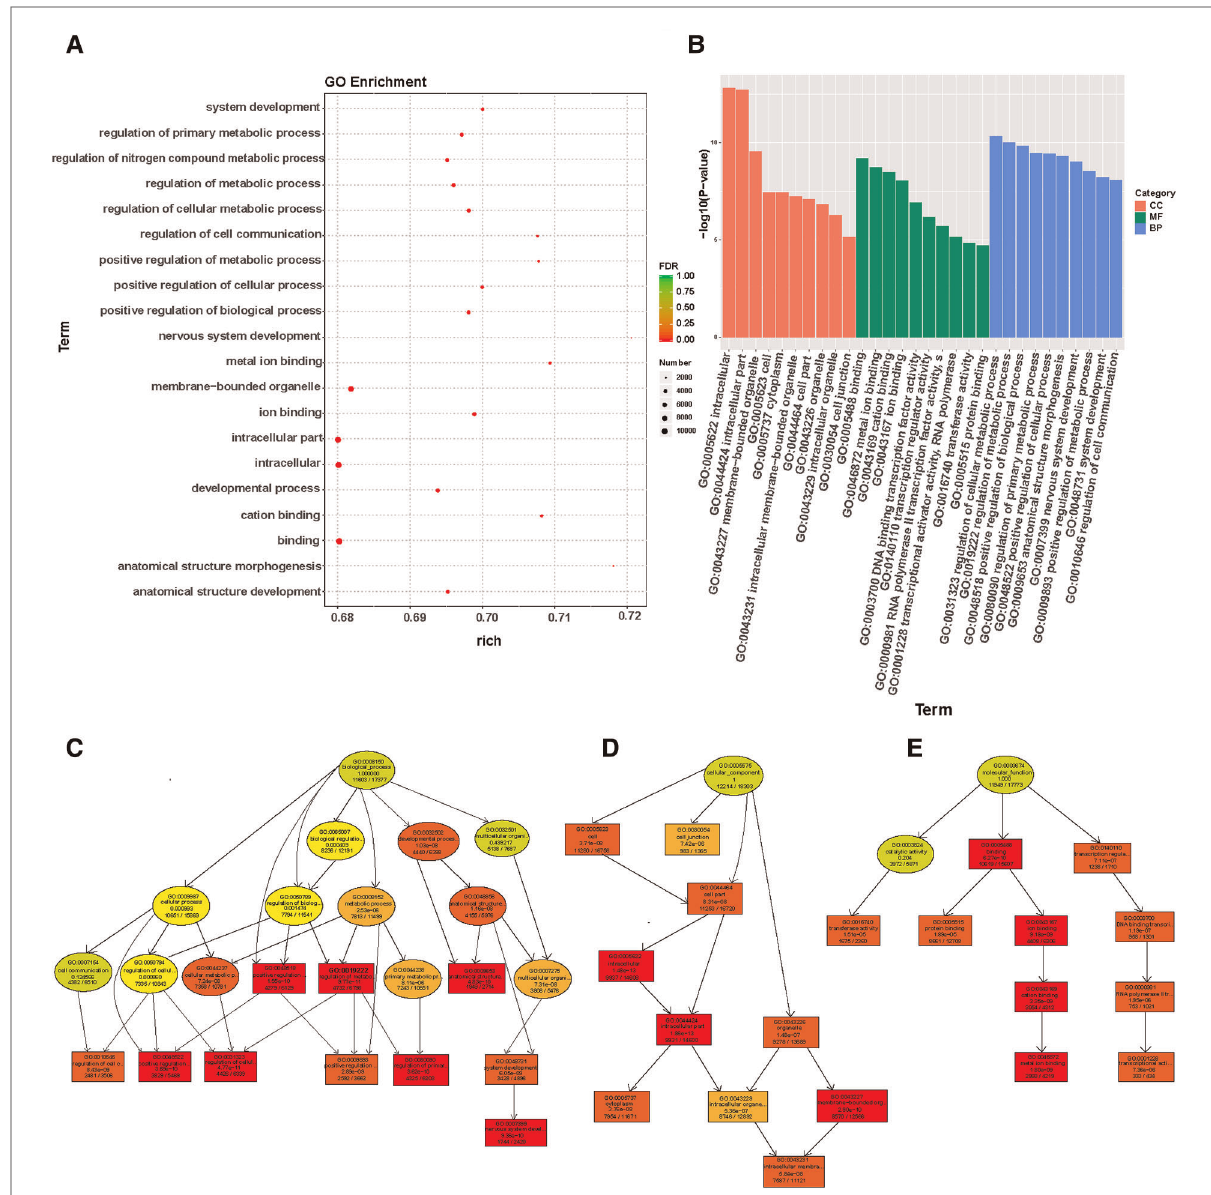
FIGURE 4 Go enrichment analysis of miRNAs expression in wound tissues of diabetic patients: ( A ) The fi rst 20 GO term entry columns with differential expression of miRNAs in diabetic wound tissues, GO with level 2 coordinates at the abscissa, and term enriched by each term. ( B ) GO enrichment analysis of differentially expressed miRNAs in wound tissues of diabetic patients. ( C ) GO-BP map of the target genes in wound tissue of diabetic patients. ( D ) GO-CC map of the target genes in wound tissue of diabetic patients. ( E ) GO-MF map of the target genes in wound tissue of diabetic